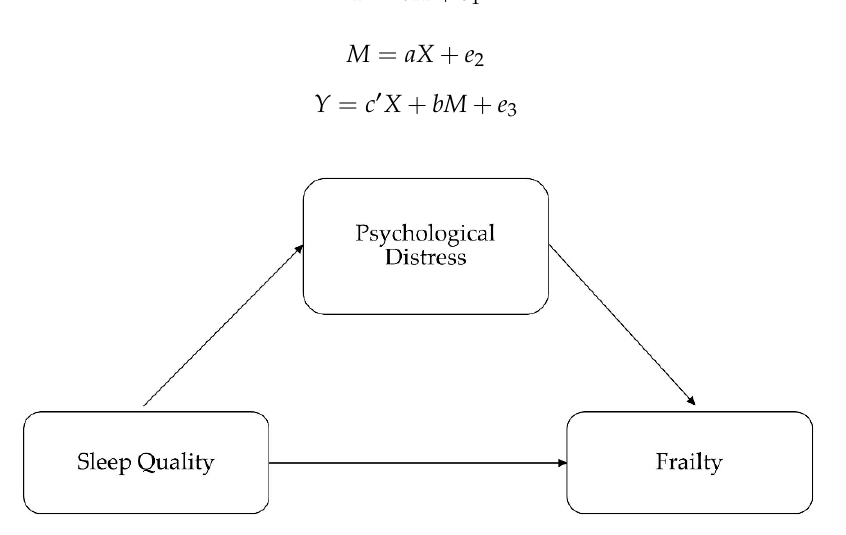
Figure 1. Diagram of the mediation model.